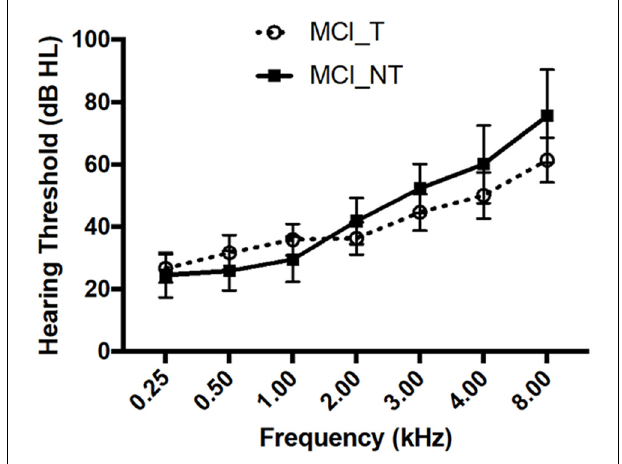
FIGURE 1 | No significant differences in hearing thresholds across all frequencies were observed between mild cognitive impairment (MCI)